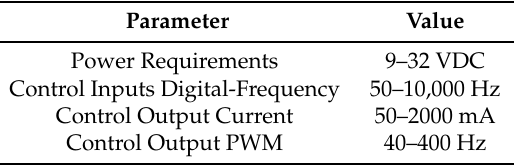
Table 5. EVDR-0101A Driver Specifications.